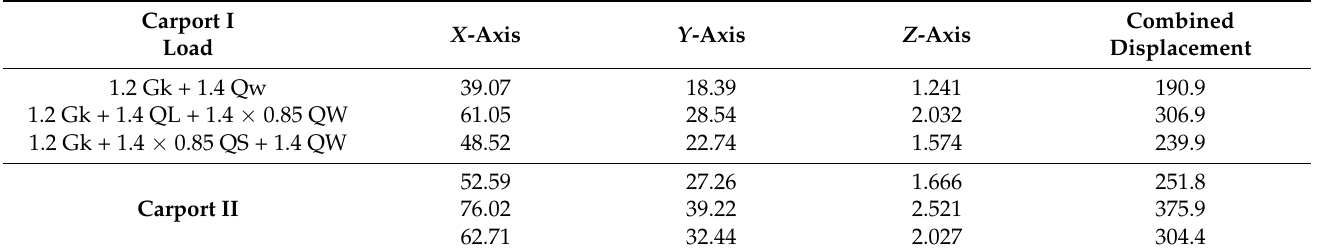
Table 6. Carport I and carport II nonlinear maximum displacement values in each direction